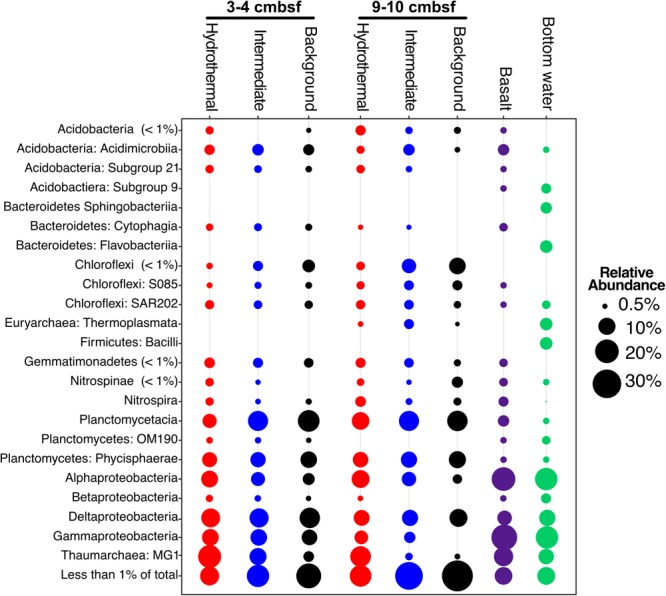
Taxonomic abundance of classes over 1% of the total community in Dorado Outcrop sediment, basalt, and bottom seawater samples based on 16S rRNA gene sequencing using the EMP primer pair (515F – 806R). Basalts and bottom seawater data from Lee et al. (2015).